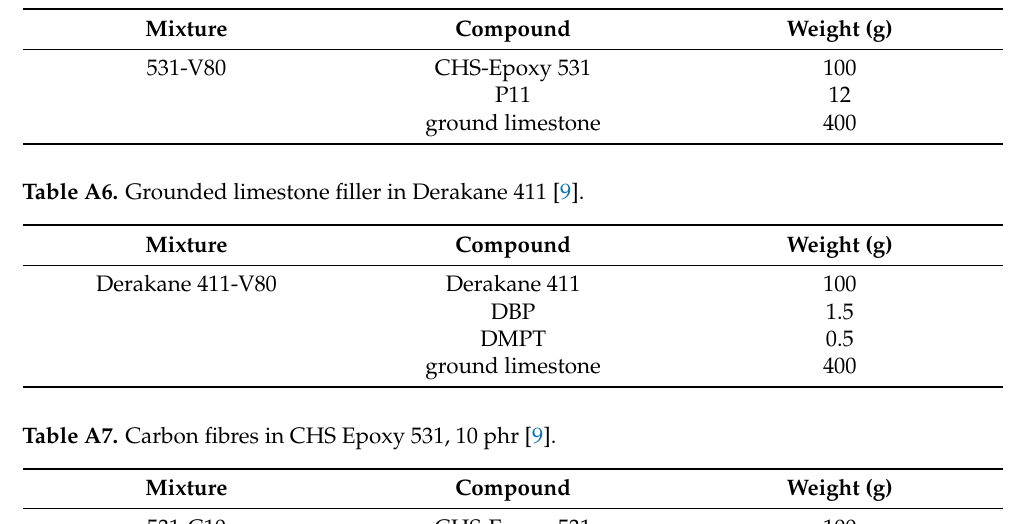
Table A5. Grounded limestone filler in CHS Epoxy 531 [9].